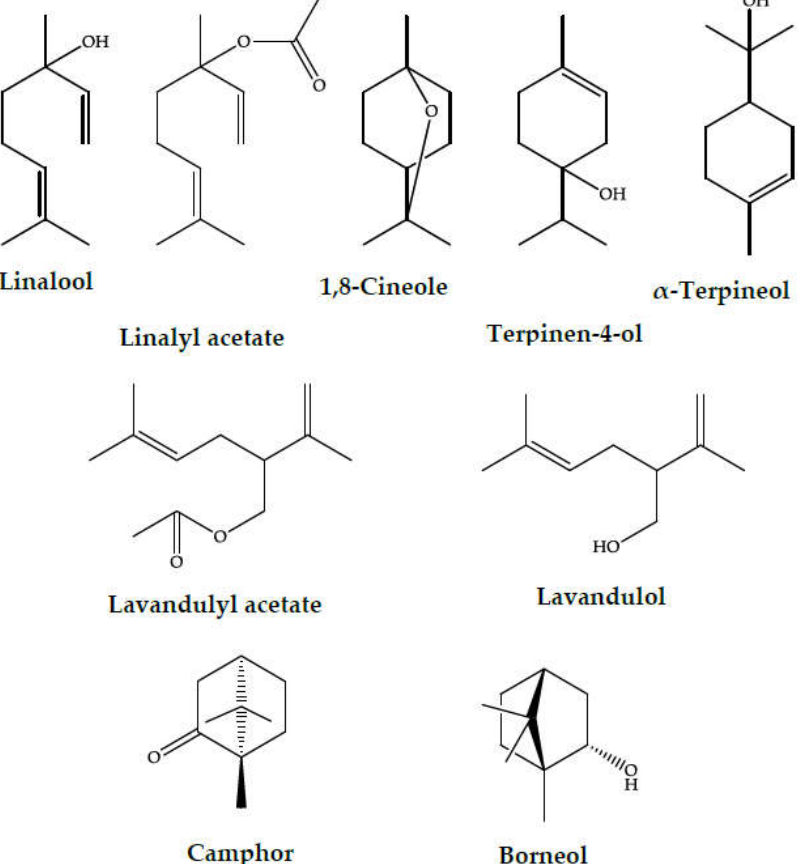
Figure 4. The characteristic monoterpenoids in lavandin essential oil.